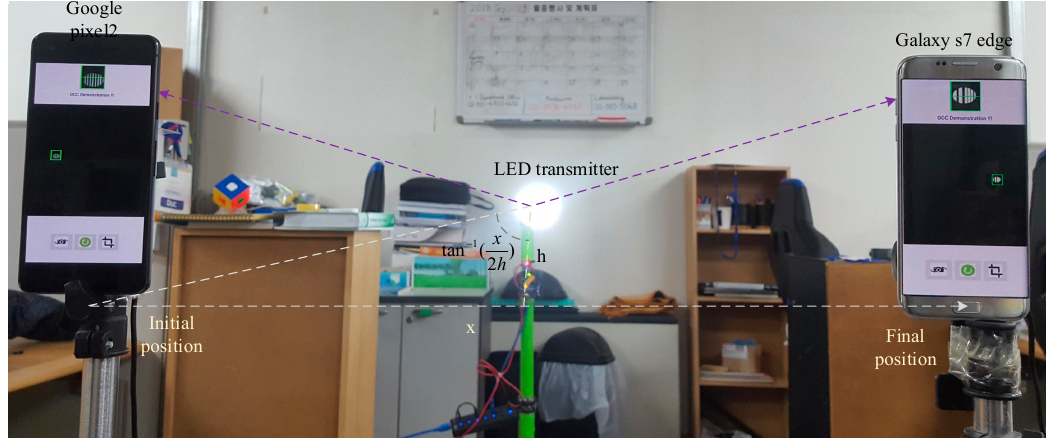
Figure 10. Demonstrations of the OCC using Google pixel2 and Samsung Galaxy s7 edge smartphone.